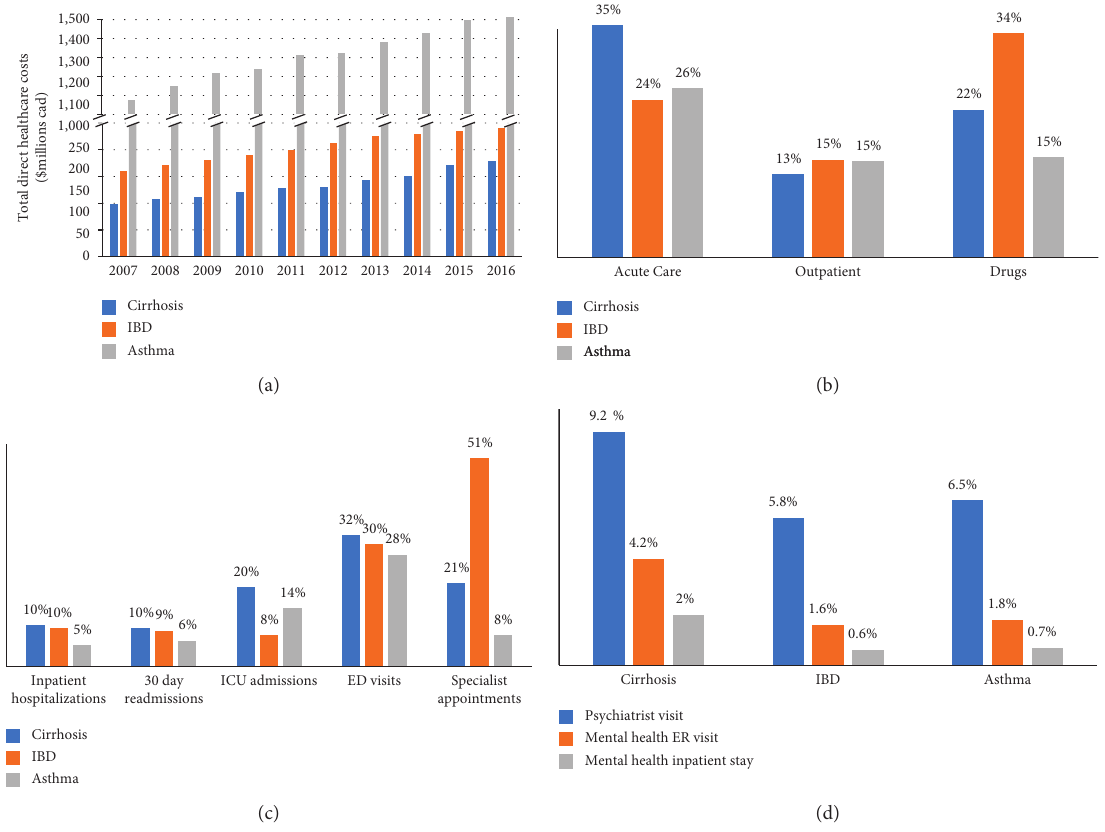
Figure 2: (a) Overall direct healthcare costs for young adults with chronic disease in Ontario (2007–2016). (b) Proportion of annual direct healthcare costs in young adults with chronic disease in Ontario 2016 stratified by resource type. (c) Proportion of young adults with chronic disease utilizing healthcare resources in 2016 in Ontario. (d) Proportion of young adults with chronic disease utilizing mental health resources in 2016 in